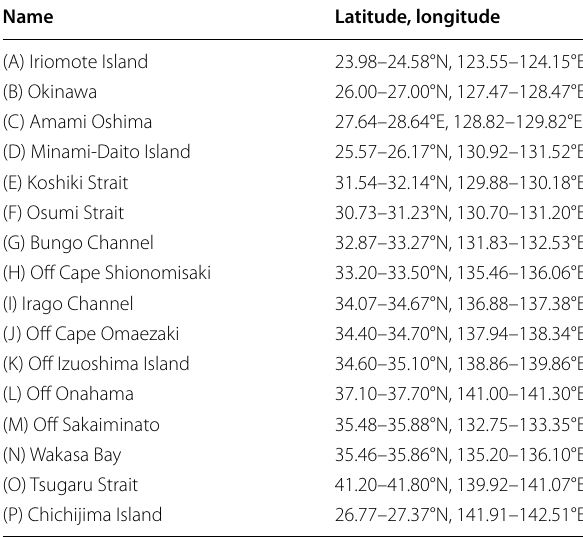
Table 3 Target areas selected for the second particle tracking simulation